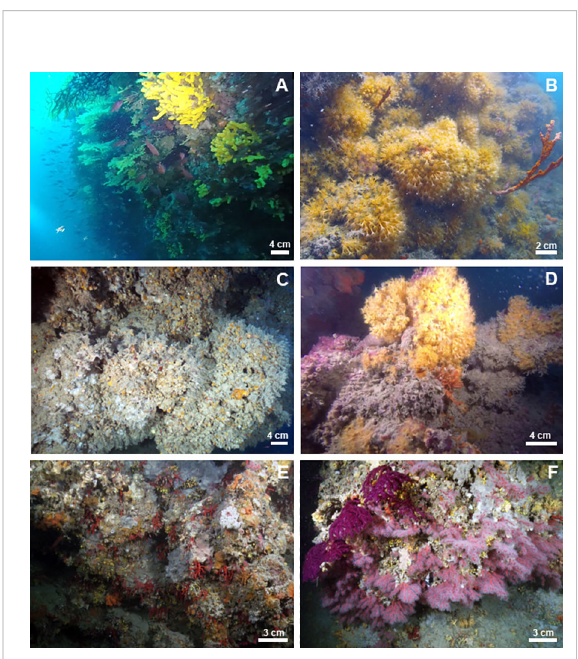
FIGURE 8 Underwater images of the megabenthic assemblages associated with the studied mesophotic bioconstructions: (A) TRM, (B) MON, (C) CAP, (D) SFC, (E) OTR, and (F)